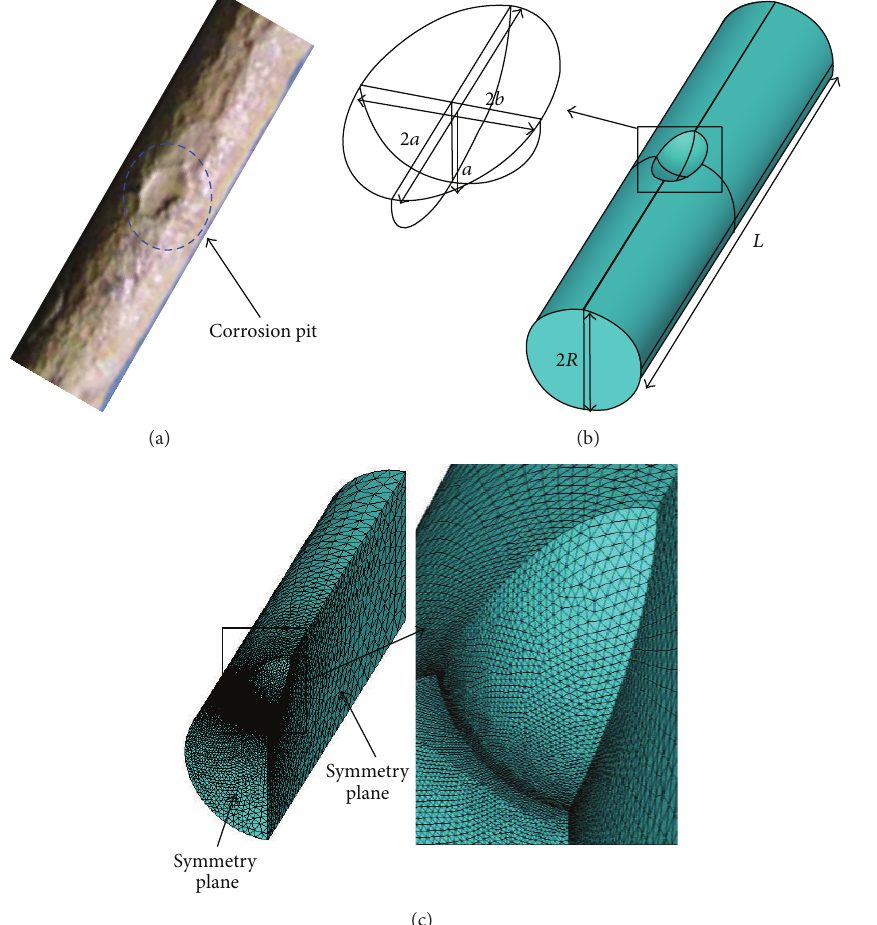
Figure 1: Illustration of single pit problem: (a) photo of corrosion pit; (b) geometric configuration of steel bar and corrosion pit; (c) finite element